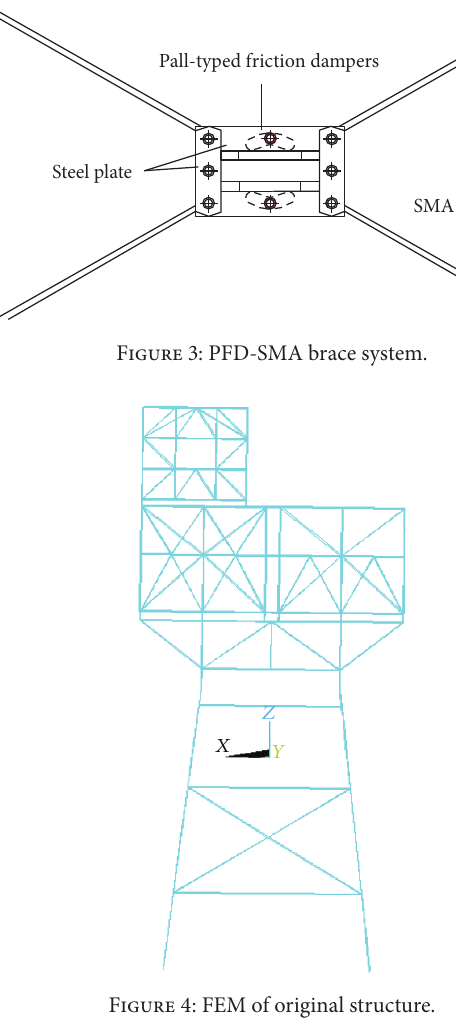
Figure 4: FEM of original structure.